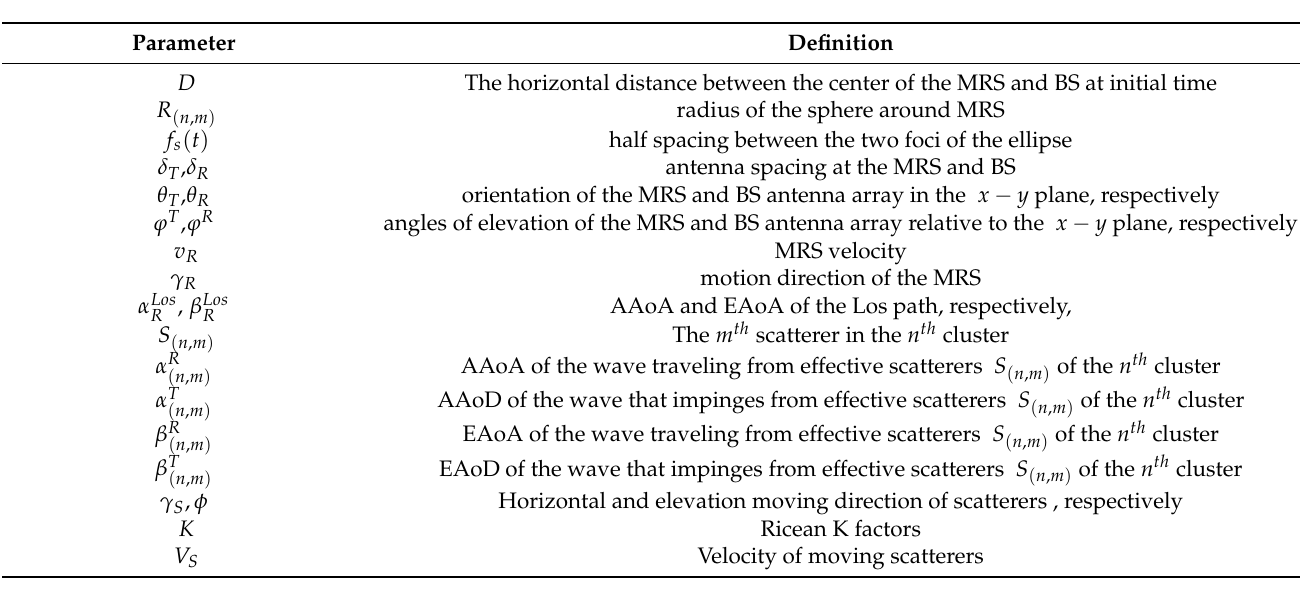
Table 1. Definition of